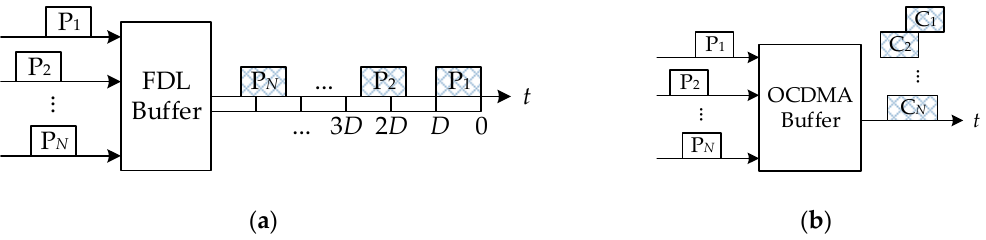
Figure 1. Optical buffering scheme based on ( a ) fiber delay line (FDL) and ( b ) optical code-division multiple access (OCDMA).